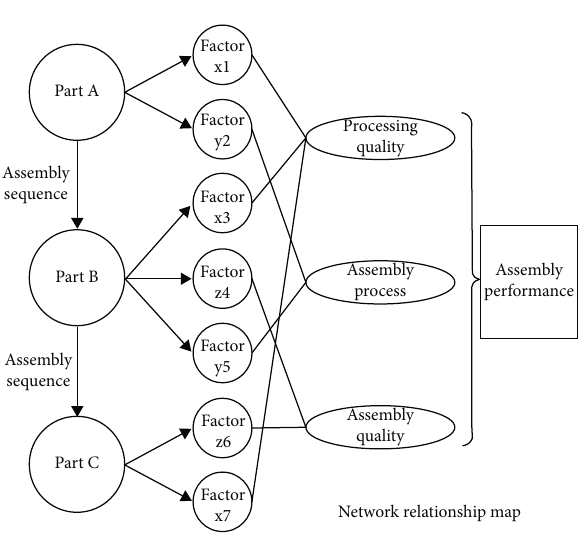
Figure 2: Complex relational network